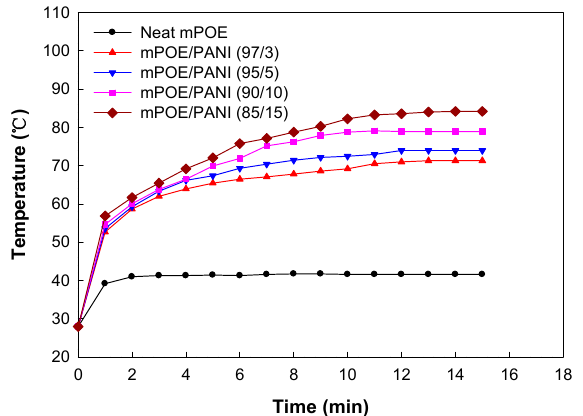
Figure 6. Variation in surface temperature with NIR irradiation time of mPOE/PANI blends.